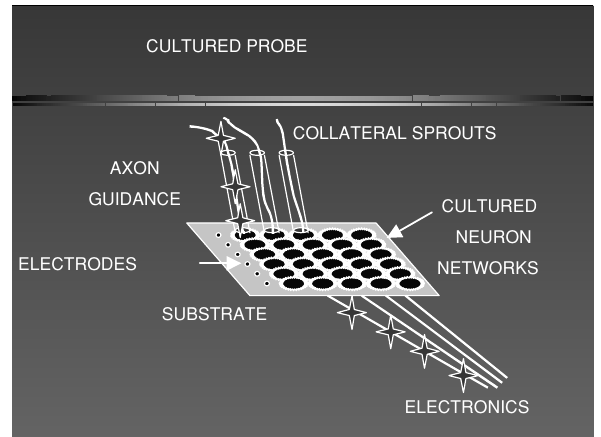
Figure 1 Schematic impression of a “cultured probe”-type of neural information transducer/prosthetic device. The black circular “stand-alone-islands” are cultured neuronal networks, separated from each other, at and around each electrode, acting as biofriendly hosts/attractors for the sprouts. The primary goal is selective stimulation of neuronal sprouts (motor fibers). The series of stars stand for information flow from one electronic stimulus channel to one neural fiber, via one electrode site.